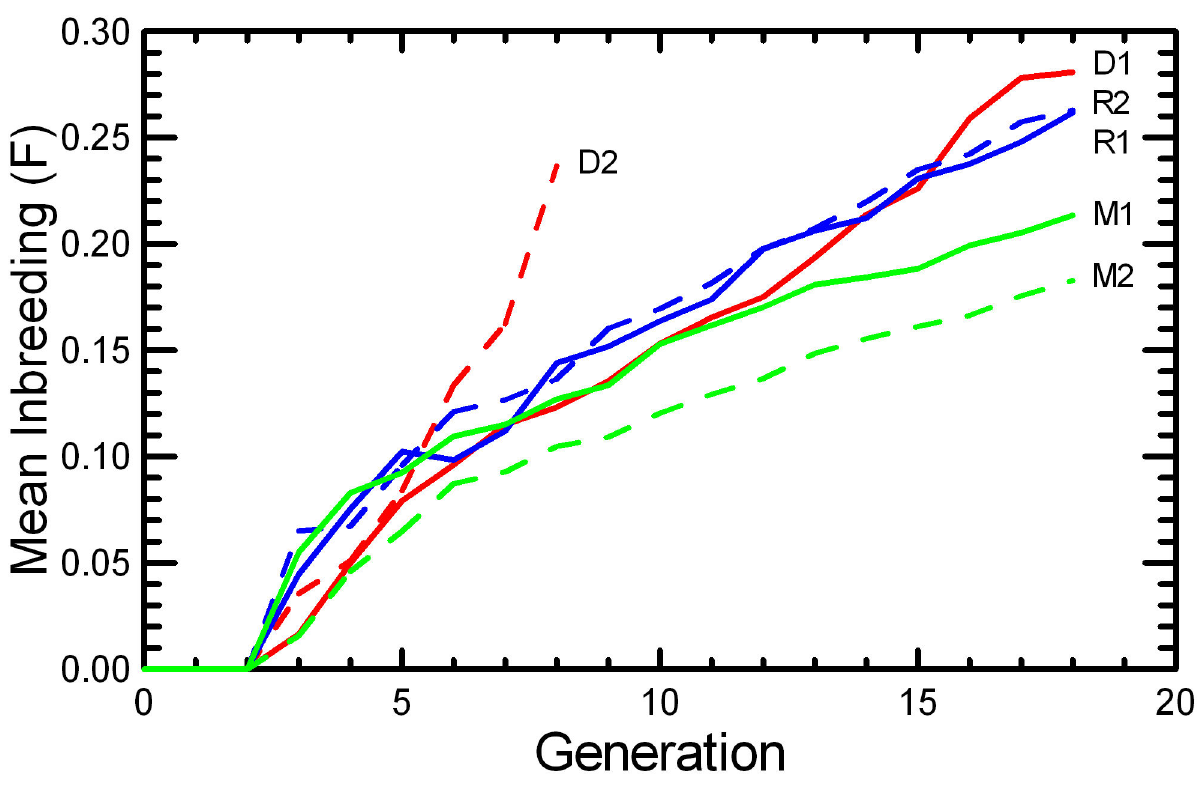
Figure 2. Accumulated inbreeding under three breeding protocols. The mean inbreeding coefficient (F) at each generation accumulated in closed populations of 20 pairs per generation is given for the two replicates of RAN (blue), MK (green), and DOC (red) experimental